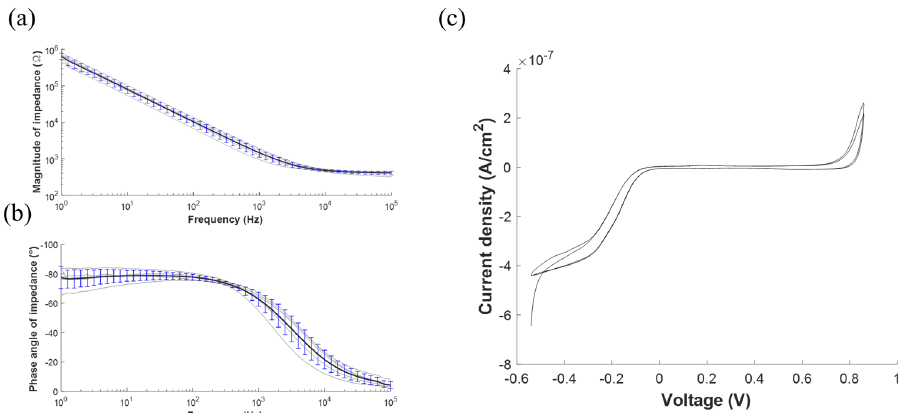
Figure 5. Electrochemical characterization of the stimulation electrodes array. ( a ) Electrochemical impedance spectroscopy (EIS) measurements as represented by the mean (black line) and the standard deviation (blue bar) of the ( a ) magnitude and the ( b ) phase angle of the impedance. The typical ( c ) cyclic voltammetry (CV).